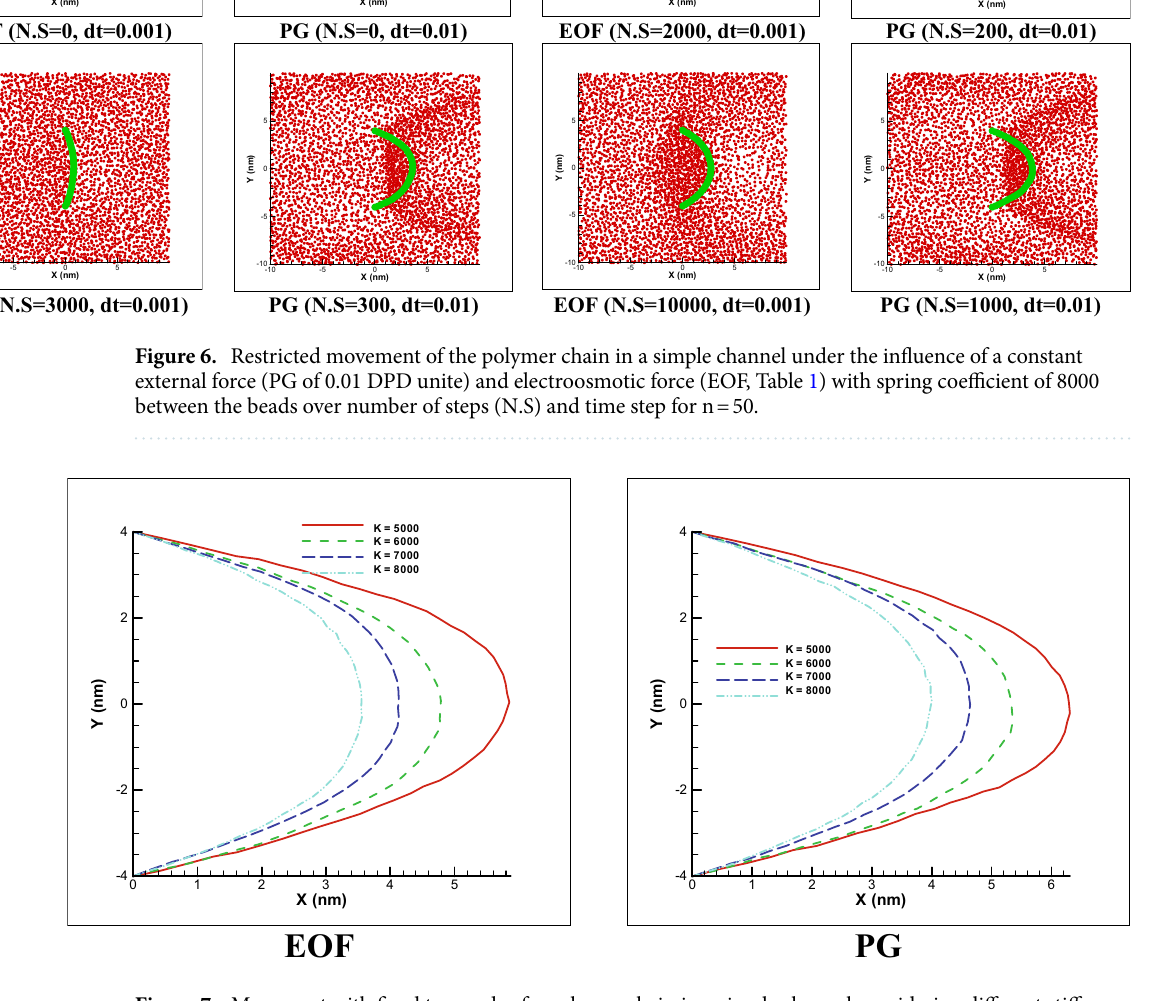
Figure 7. Movement with fixed two ends of a polymer chain in a simple channel considering different stiffness coefficient for both pressure gradient and electroosmotic flow test cases (n =